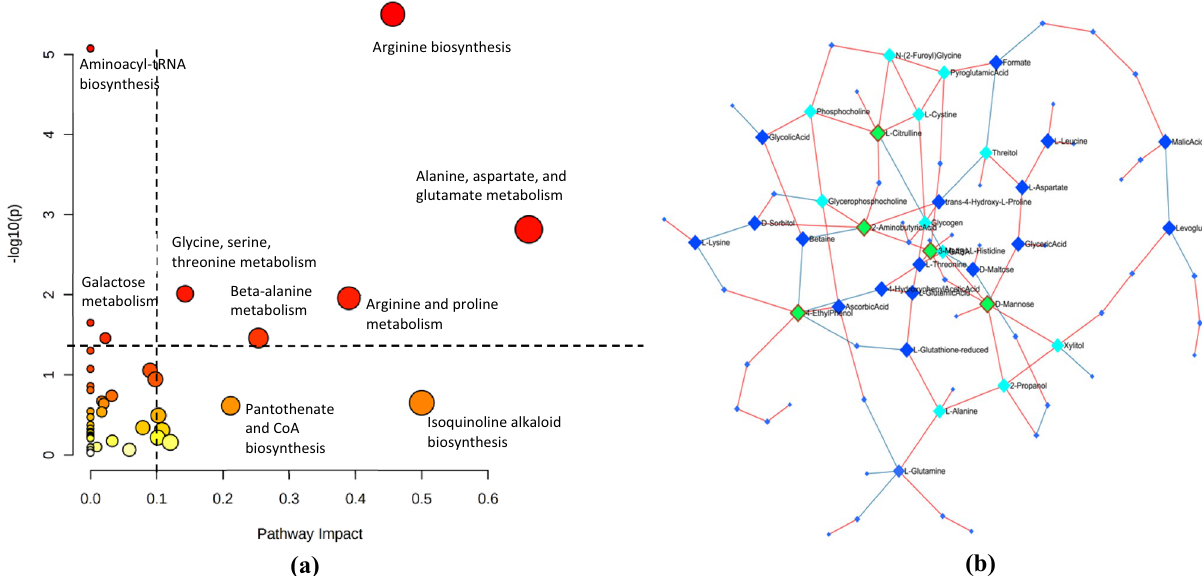
Figure 5. ( a ) Analysis of altered metabolic pathways based on distinguishing metabolites found in oil palm stem tissue with various BSR severity indices. ( b ) DSPC network analysis of all indices of oil palm stems infected by G. boninense . Red edges indicate positive correlations, and blue edges indicate negative correlations. Green nodes indicate nodes with the highest node degree and betweenness centrality. Severity